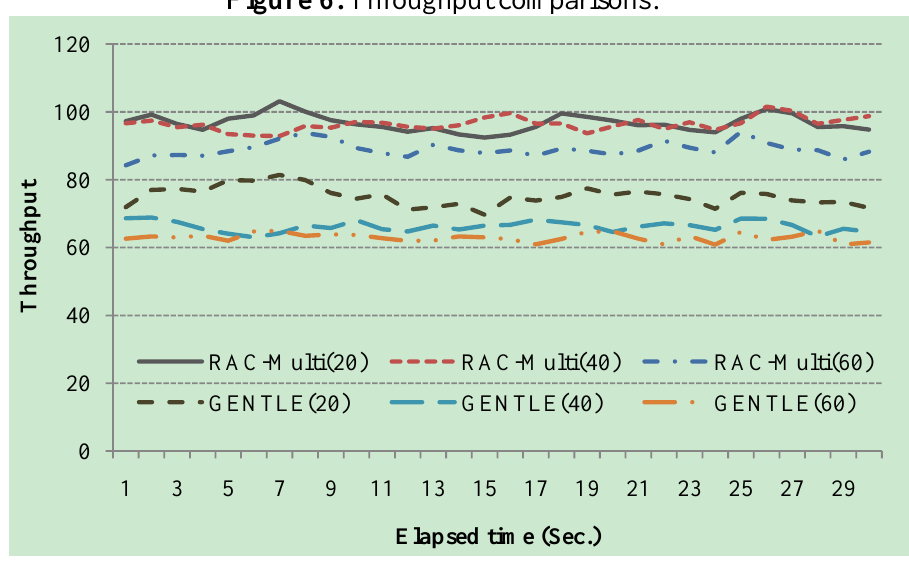
Figure 6. Throughput comparisons.